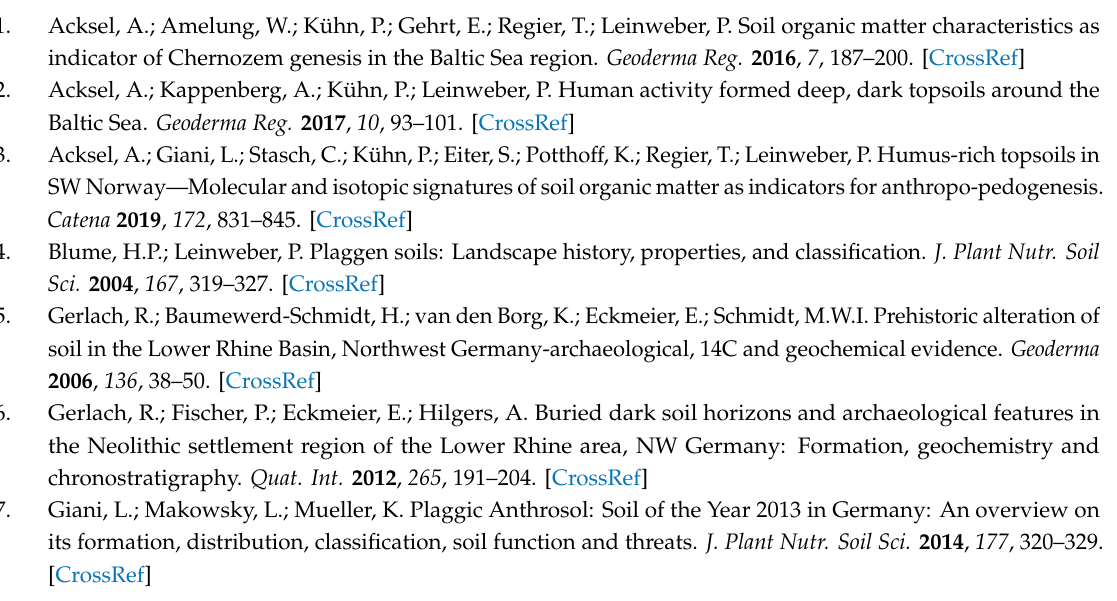
Figure S1: Soil profiles at the island of Poel in Germany (P-4 and P-3), of Sjaelland in Denmark (S-7) and of Fehmarn in Germany (F-8), Table S1: P concentrations and proportions of the detected P-species of 31P-NMR spectra of 6 Northern European Anthrosols (F: Feøy; S: Sandhåland; PE1: Njærheim; S7: Vordingborg; F-6: Großenbrode; P-3: Niendorf), Figure S2: LCF results of the soil samples F-6 41-53 and Hi